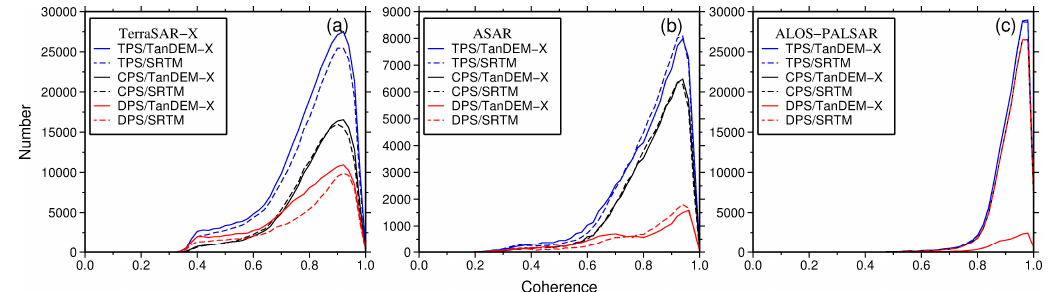
Figure 13. Coherence of the three platforms with two different external DEMs: ( a – c ) the coherence histograms of X, C and L bands, respectively. Blue, black and red solid lines represent the coherence histograms of TPS, CPS and DPS with TanDEM-X DEM, respectively. Blue, black and red dashed lines represent the coherence histograms of TPS, CPS and DPS with SRTM-1arc DEM, respectively.